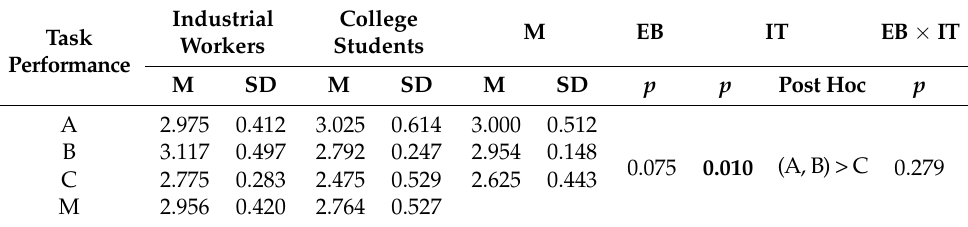
Table 1. Descriptive statistics and two-way ANOVA on task performance (unit: